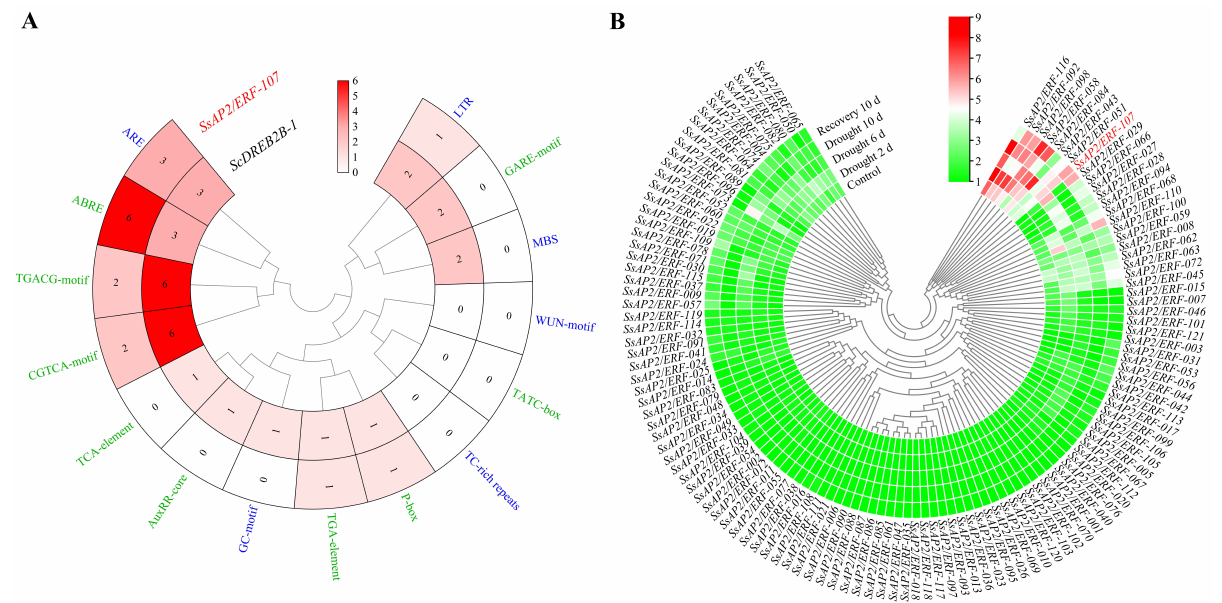
Figure 4. Promoter elements analysis of the ScDREB2B-1 gene and expression profiles of the Saccharum spontaneum SsAP2/ERF gene family under drought stress. ( A ) Promoter elements analysis between ScDREB2B-1 and its homologous gene SsAP2/ERF-107 in S. spontaneum . Green and blue fonts represented hormone responsive elements and environmental stress-related elements, respectively. ( B ) Expression profiles of S. spontaneum SsAP2/ERF gene family under drought stress. The red font was SsAP2/ERF-107 , which was a member of the ERF subfamily and a homologous gene of ScDREB2B-1 . The expression heat map of SsAP2/ERF was constructed by TBtools with the transcript level transformed by log 2 (FPKM + 1). FPKM mean fragments per kb per million.